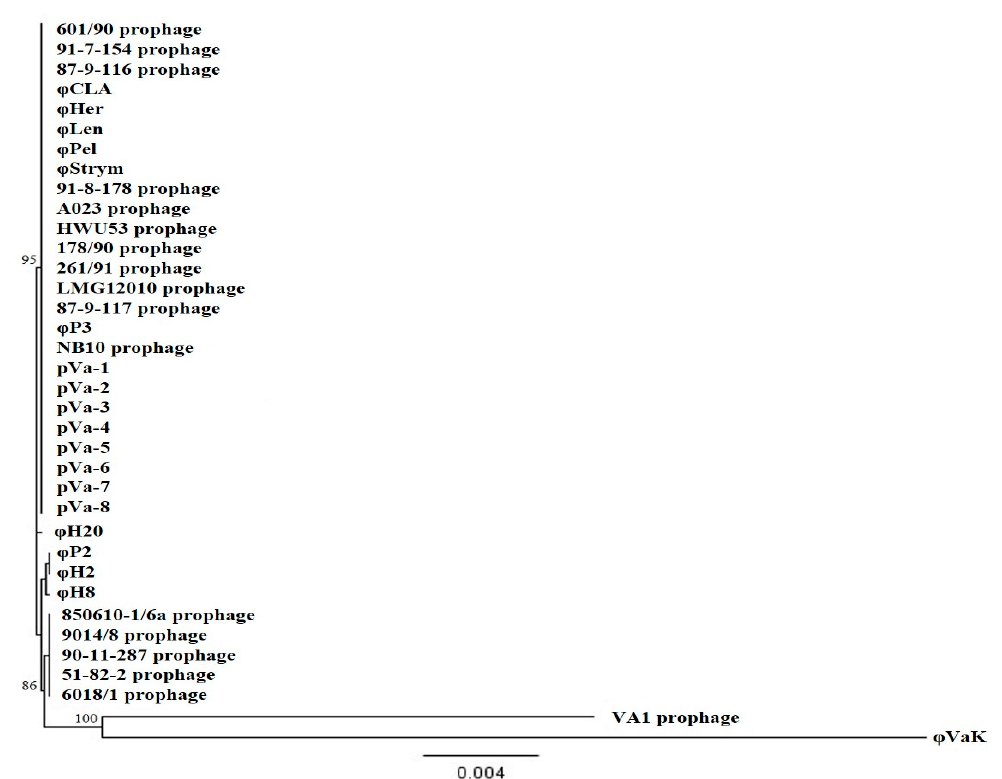
Figure 5. Phylogenetic tree (Neighbor-Joining method) based on the whole genomes of the 19 temperate bacteriophage isolates of the current study and 17 prophages which were bioinformatically detected in the genome of their V. anguillarum hosts. The branch labels indicate the percentage of statistical support.